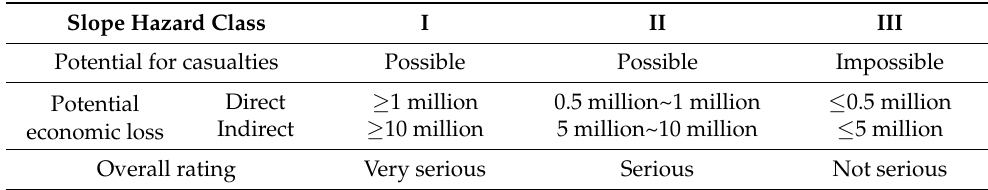
Table 2. Slope hazard class.